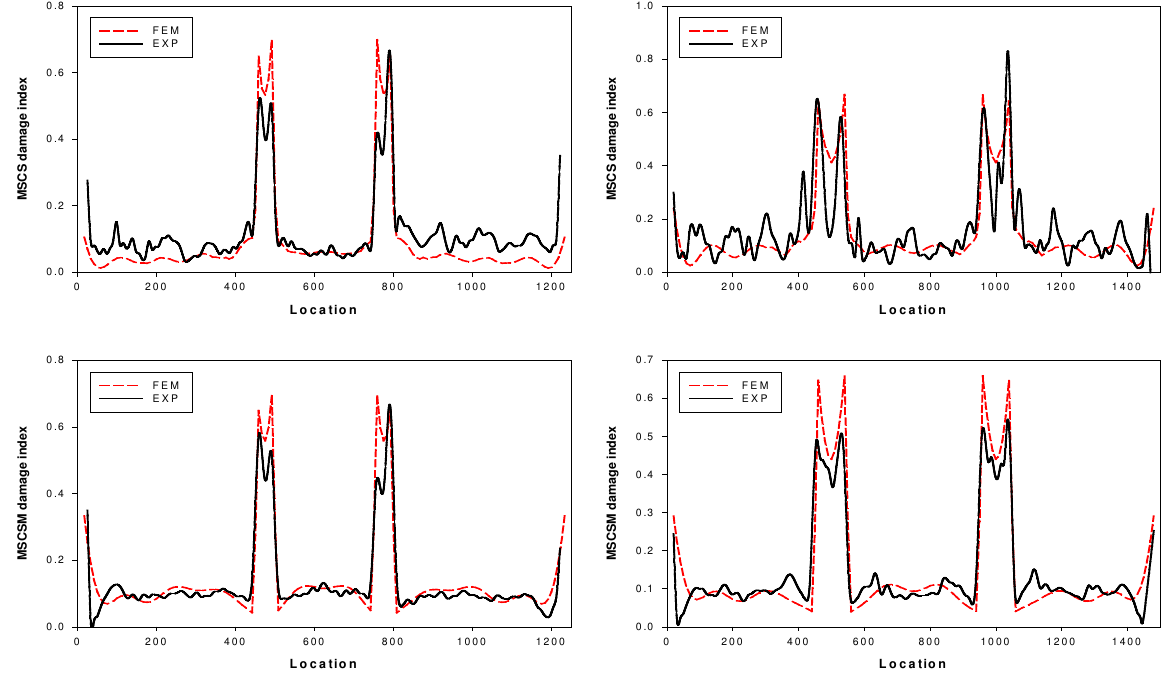
Fig 6. Damage detection methods for beams with multiple damage locations; Beam 3 – left; Beam 4 –